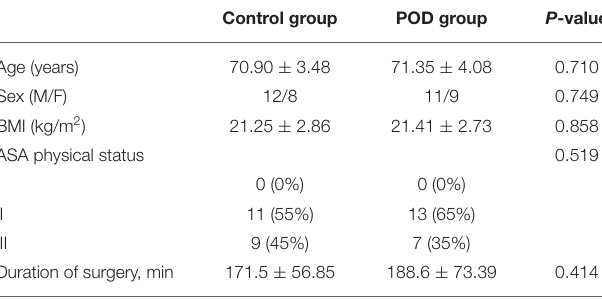
TABLE 1 | Patient